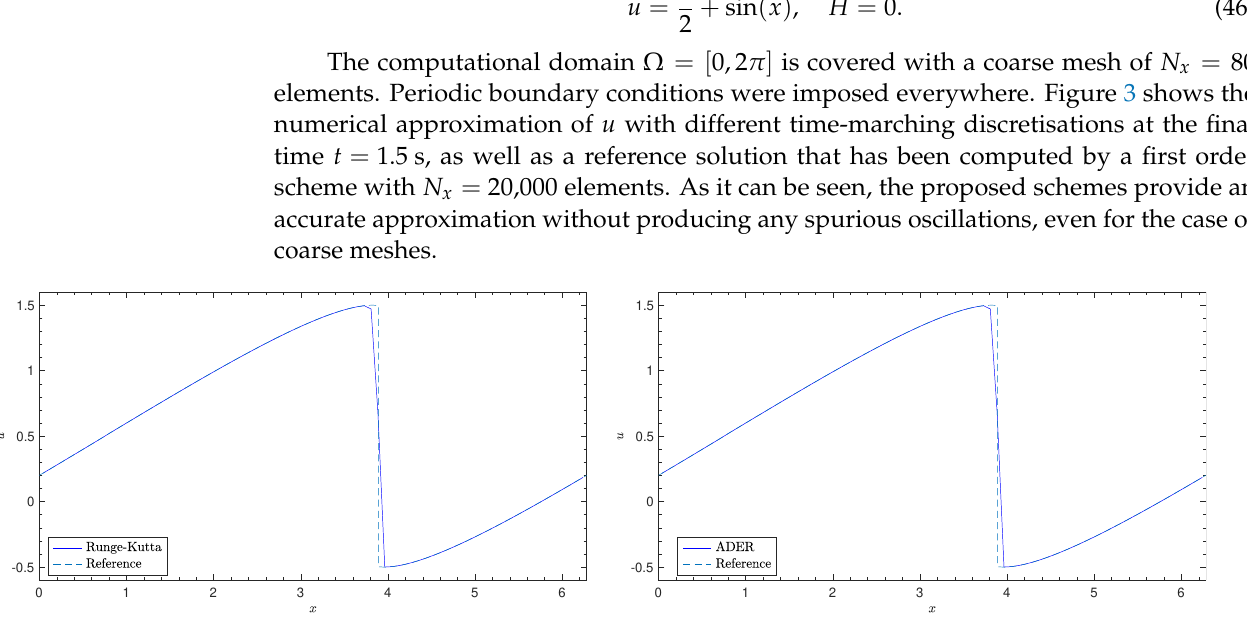
Figure 3. Computed variable u for the problem (46) (Burgers’ equation) with the fourth-order well- balanced Runge–Kutta ( left ) and ADER ( right ) numerical methods at time t = 1.5 s. An uniform Cartesian mesh of N x = 80 elements has been used.